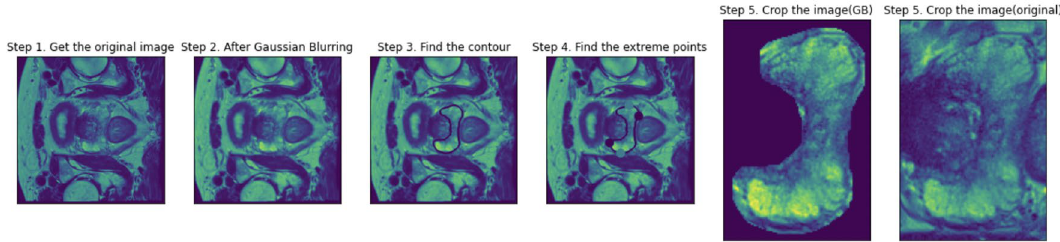
Figure 2. PZ cropping steps on one slice of the sequence. Gaussian blurring was applied to increase the contrast. Four extreme points were located based on the annotated contour. With a margin of 5 pixels, a surrounding rectangle was cropped. CG cropping follows similar steps.